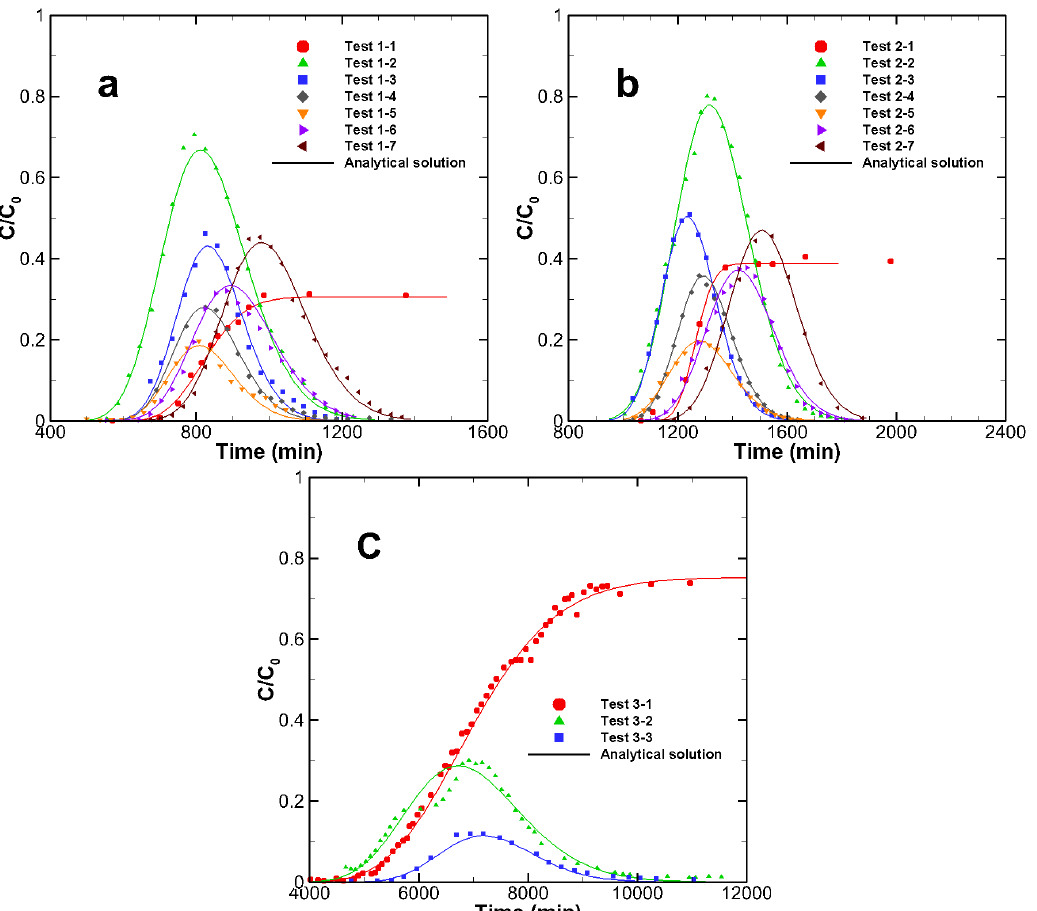
Figure 5. Breakthrough curves for ( a ) coarse, ( b ) medium and ( c ) fined sand soil layers.